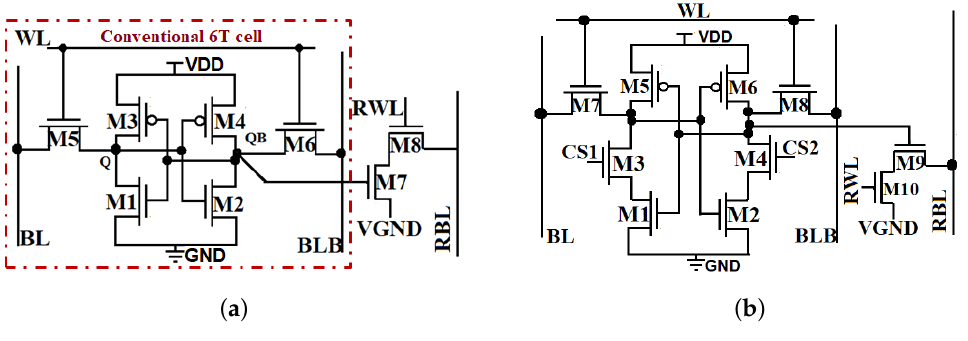
Figure 2. SRAM structure: ( a ) read decoupled 8T [19]; ( b ) PFC10T